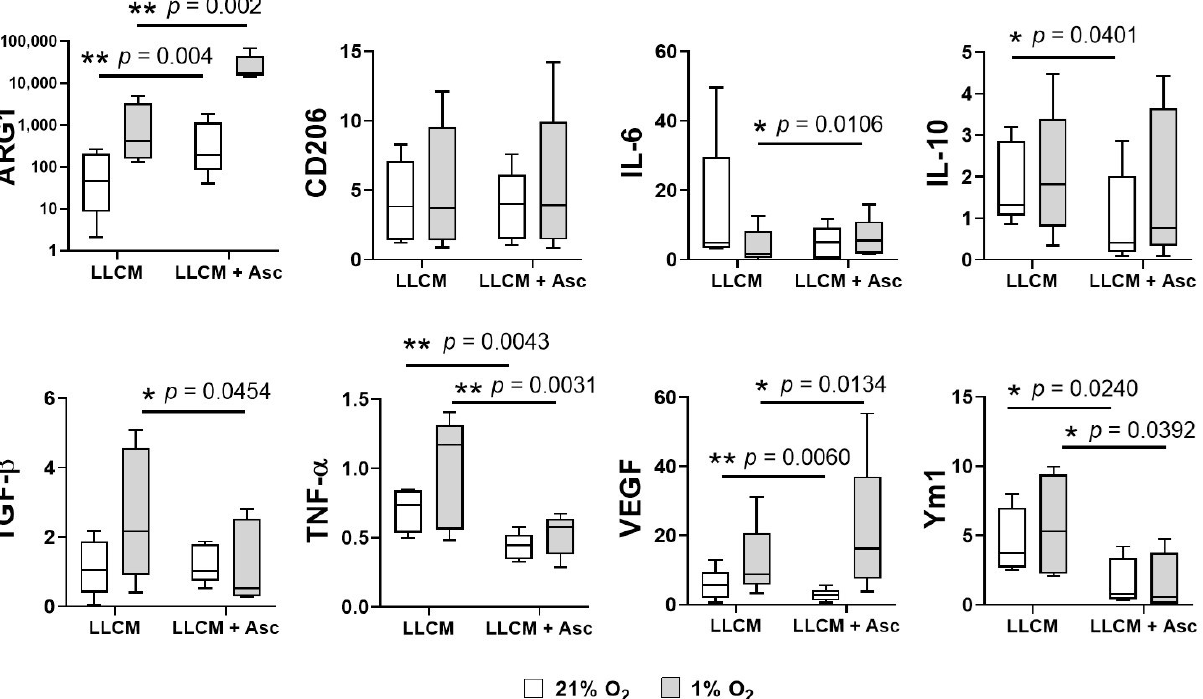
Figure 4. Gene expression analysis of LLCM-grown bone marrow derived macrophages with or without ascorbate. Isolated bone marrow cells were grown with MCSF, LLCM or LLCM + Asc for 7 days at ambient air (21% O 2 ) or subjected to hypoxia on day 6 for ~18 h (1% O 2 ). Cells were harvested for gene expression analysis by qPCR. Gene expression levels were calculated relative to bone marrow cells cultured with MCSF at 21% O 2 and presented as fold change. Cells grown in LLCM showed altered gene expression levels compared to MCSF grown cells ( left set of columns). Supplementation with ascorbate resulted in further significant gene expression changes ( right set of columns). Oxygen tension also appears to alter expression of certain genes within each LLCM and LLCM + Asc cultured condition. Box and whiskers plot represent data from 5 independent experiments, box represents 25th to 75th percentile, whiskers represent min to max value and middle line represents median. Two-tailed paired t -tests were performed, * denotes p < 0.05 and ** denotes p <